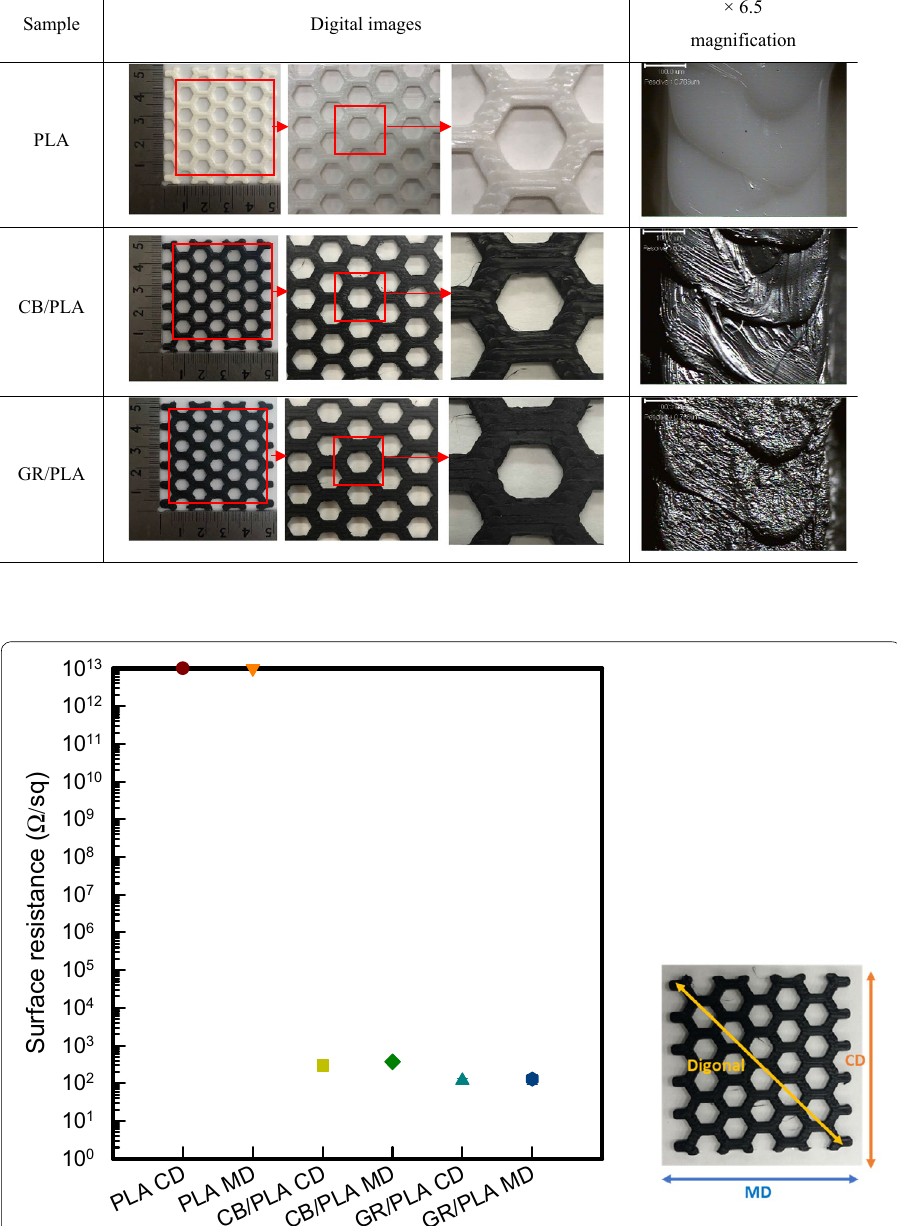
Fig. 5 Surface resistance of 3D printed honeycomb samples with various directions